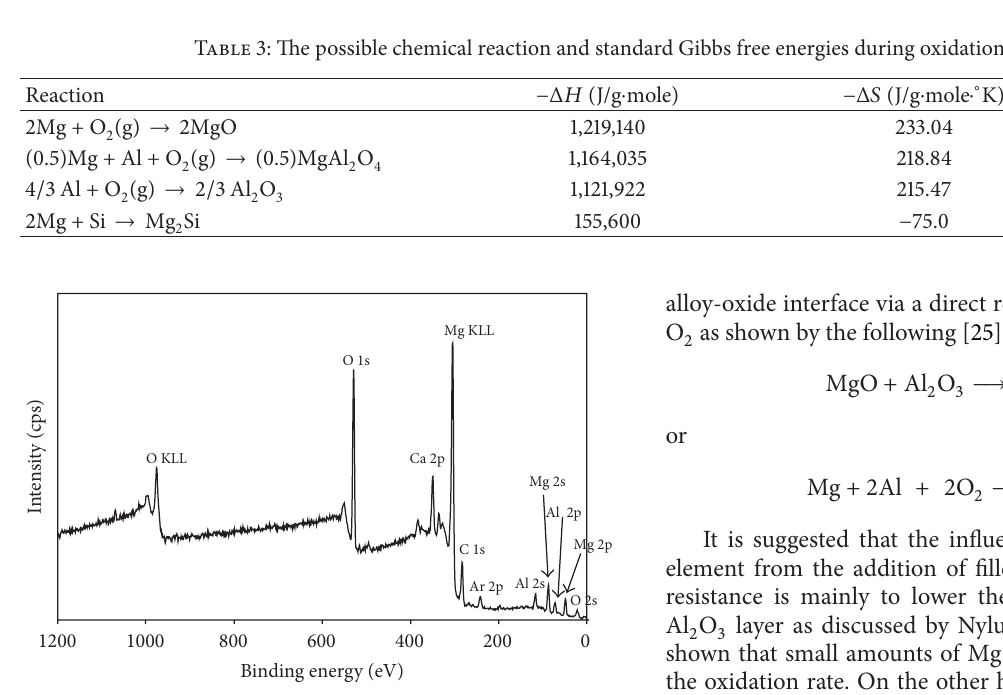
Figure 9: The wide XPS spectra of oxidized fused metal surface of AA6061 welded Al alloy at 600 ∘ C for 40 hours exposure